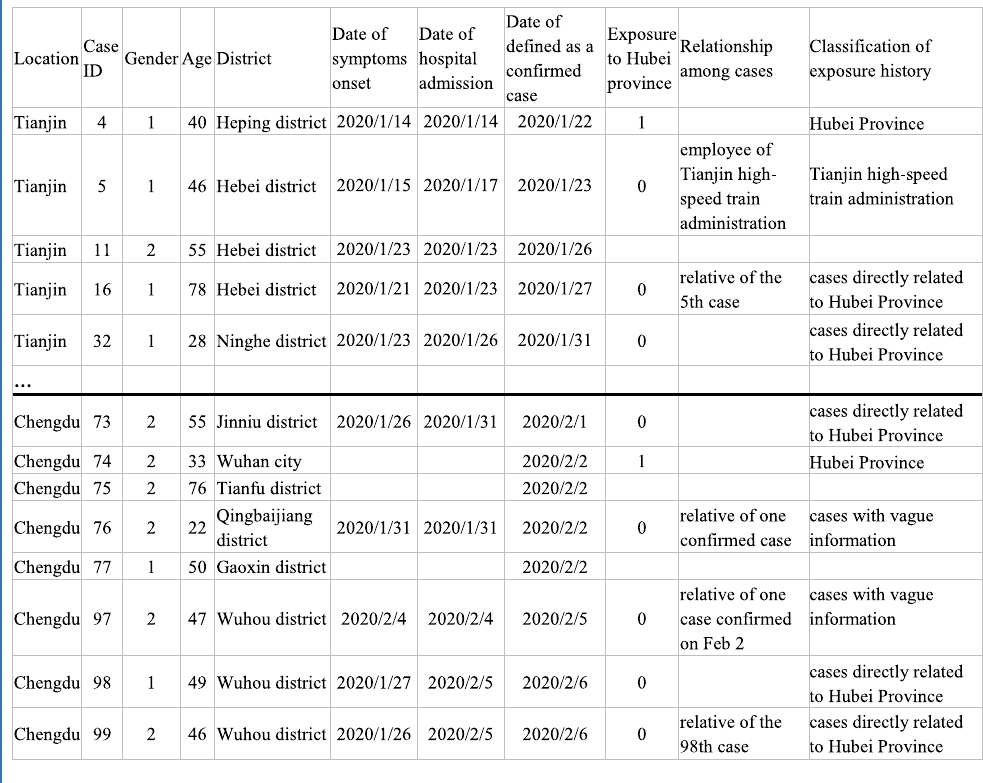
Figure 3. Example of unstructured individual reports and structured databases of Tianjin and